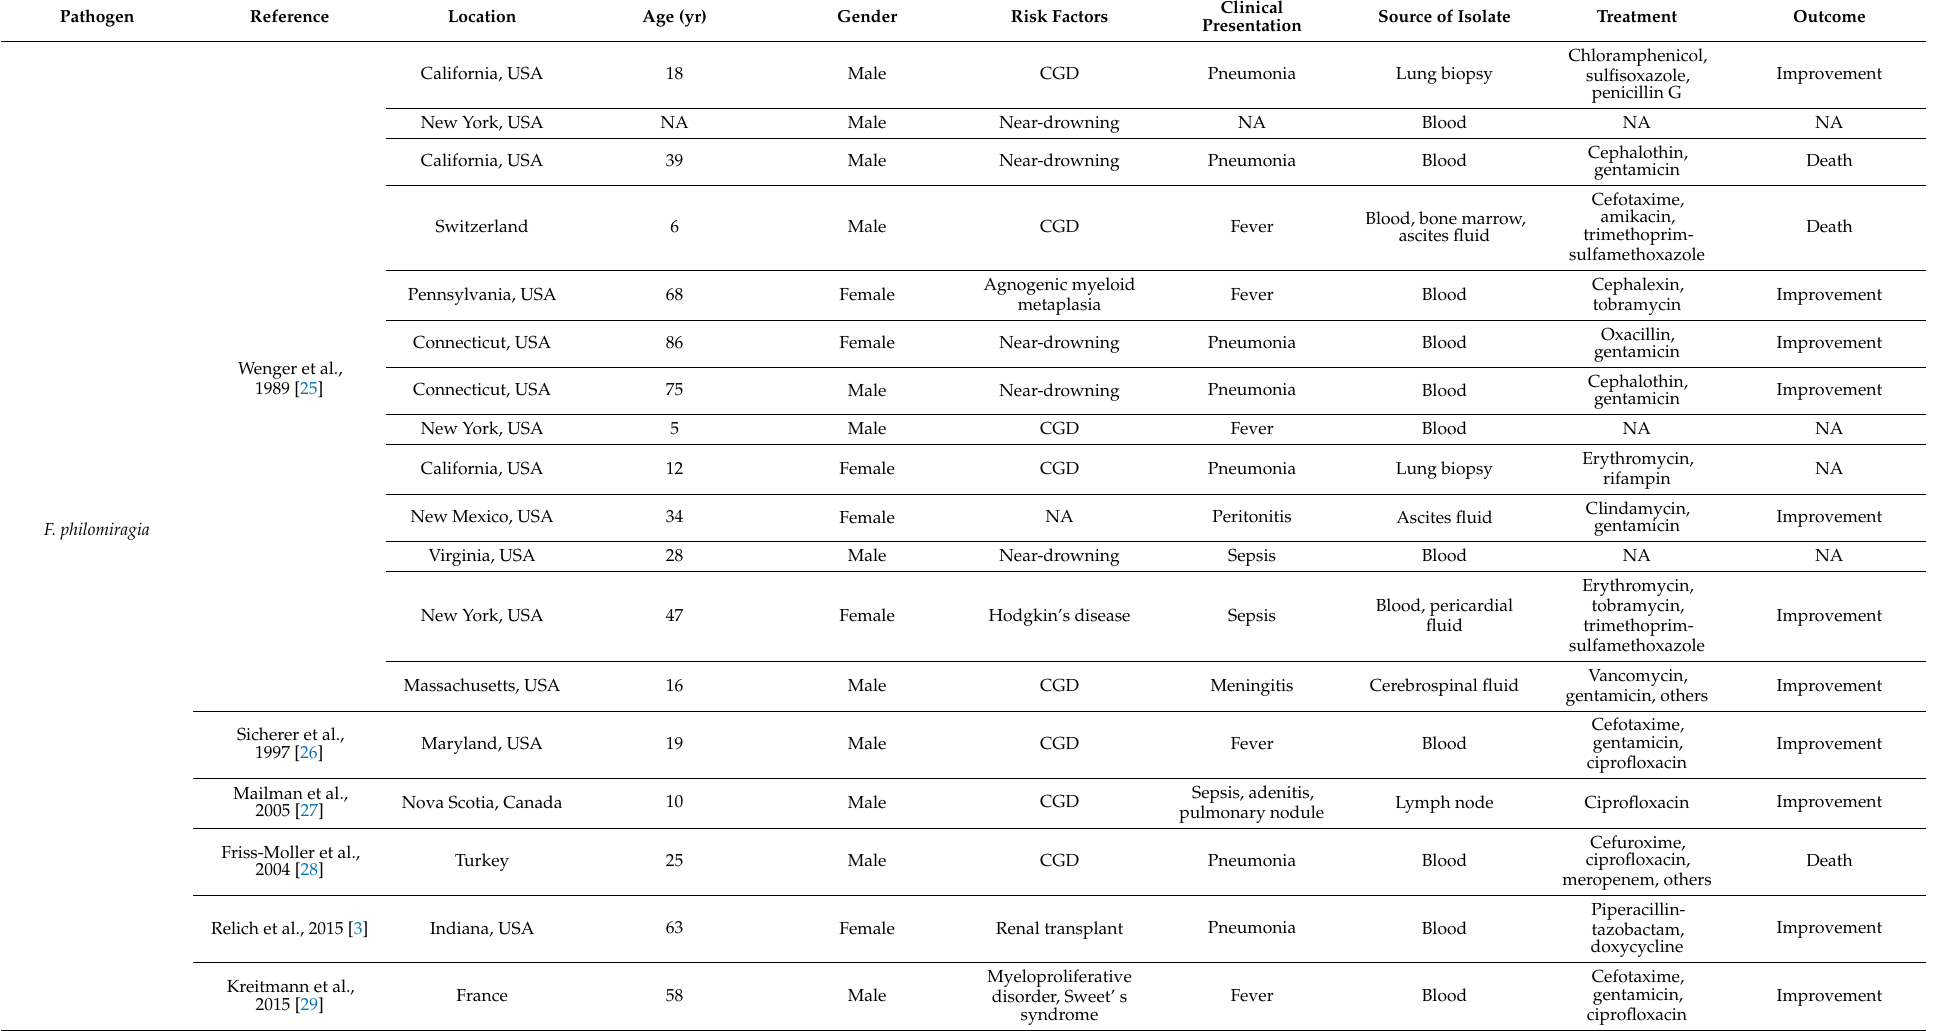
Table 1. Review of 22 clade-2 Francisella species reported cases in the